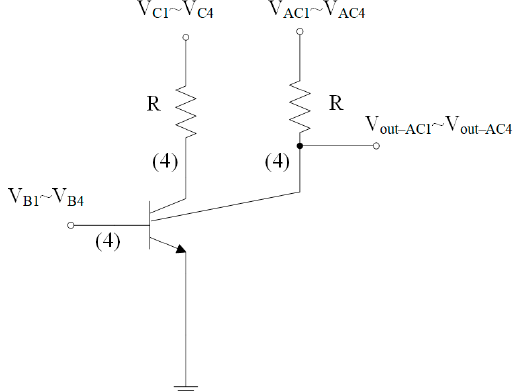
Figure 2. Equivalent circuit for the magnetotransistor. V, bias voltage; C, collector; R, resistor; AC, additional collector; B, base.